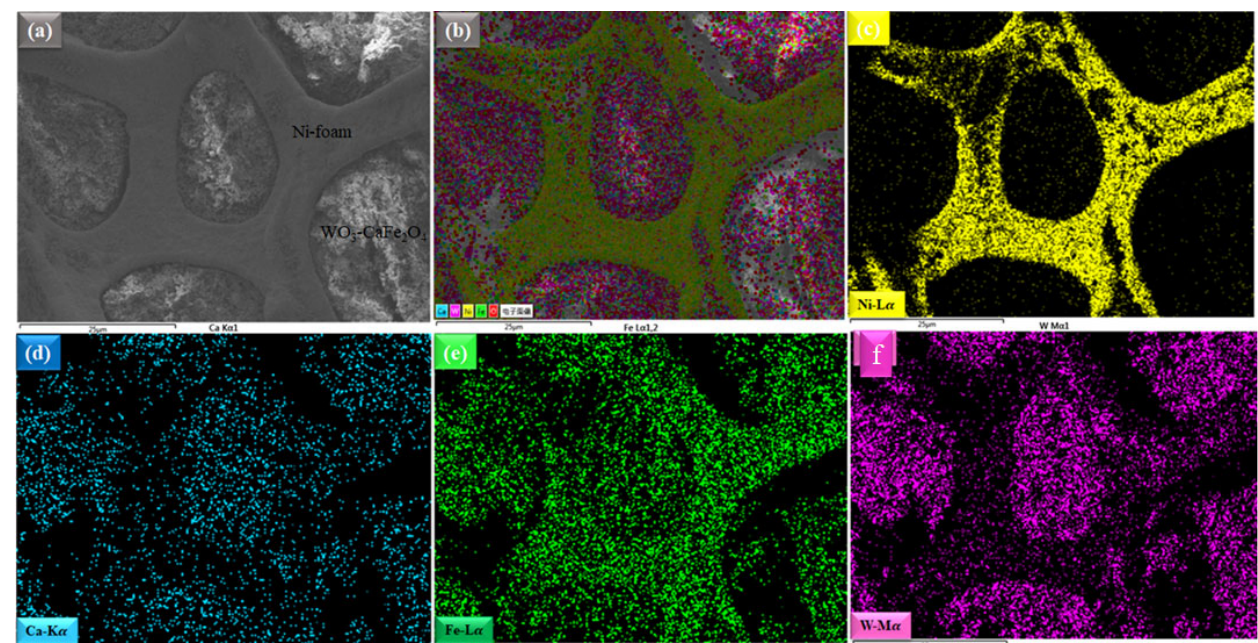
Figure 2. ( a , b ) The surface morphology studied by SEM for CaFe 2 O 4 powers, ( c , d ) SEM image for the commercially purchased WO 3 and ( e , f ) SEM image for WO 3 ‐ CaFe 2 O 4 heterostructure composite powers, respectively.